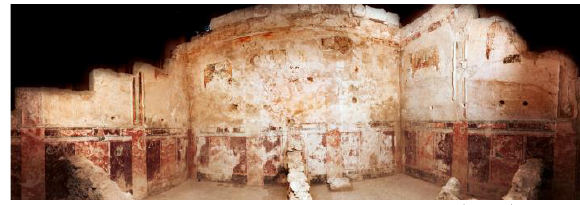
Figure 2 . The Royal Box – general view (2010)